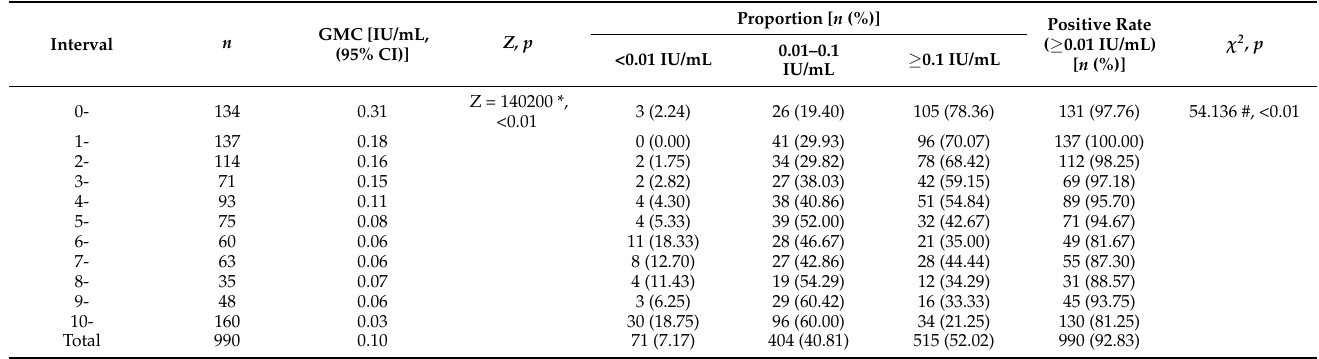
Table 5. Seroprevalence and antibody level over time following basic and booster immunization of tetanus-toxoid-containing vaccines (TTCVs).